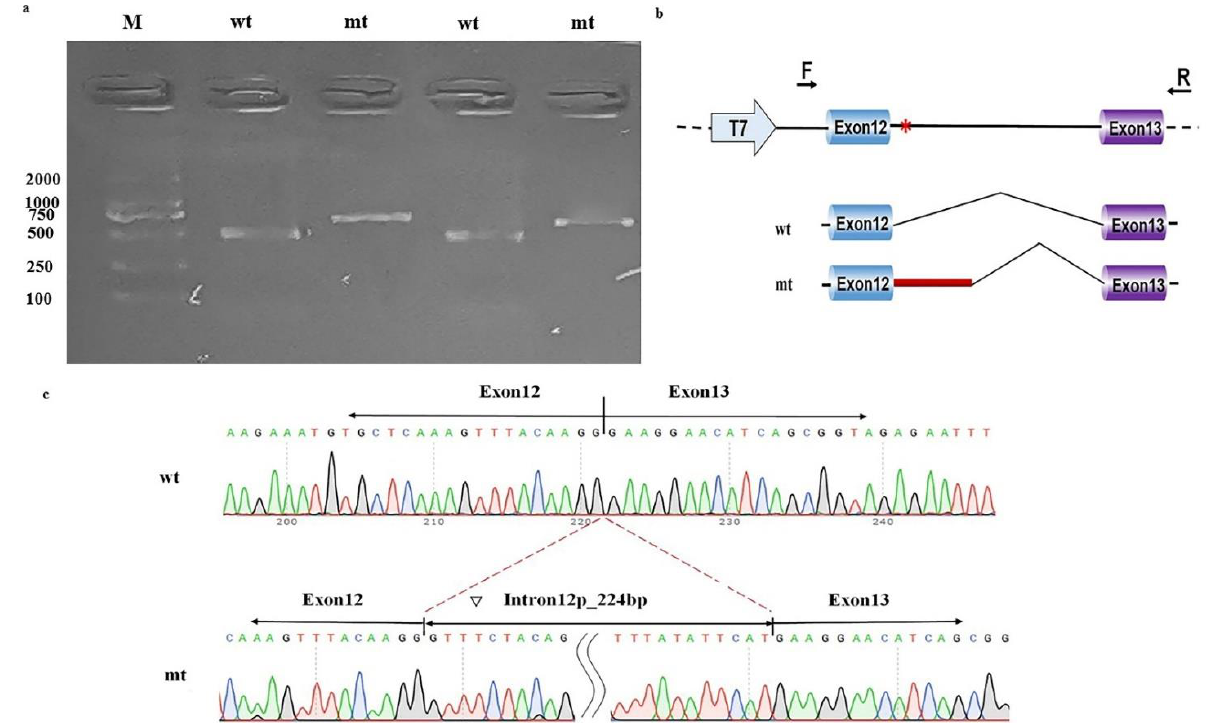
Figure 3. Minigene study on a noncanonical splice site variant in NAA15 . ( a ) Reverse-transcription polymerase chain reaction (RT-PCR) products from MCF-7 (left) and HEK-293T (right) cells transfected with either wild-type (wt) or mutant (mt) pcDNA3.1 vector were separated by electrophoresis. M: DNA marker. ( b ) Structure of the splicing vector pcDNA3.1, where the symbol “*” represents the location of the variant. ( c ) Sequencing of minigene product showed normal mRNA composing exons 12 and 13 and abnormal mRNA composing 224 bps of intron 12 besides exons 12 and 13.